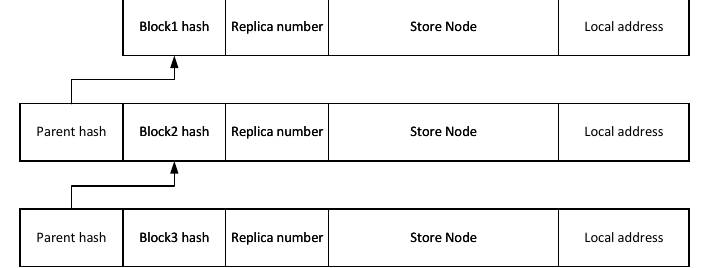
Figure 6. The virtual